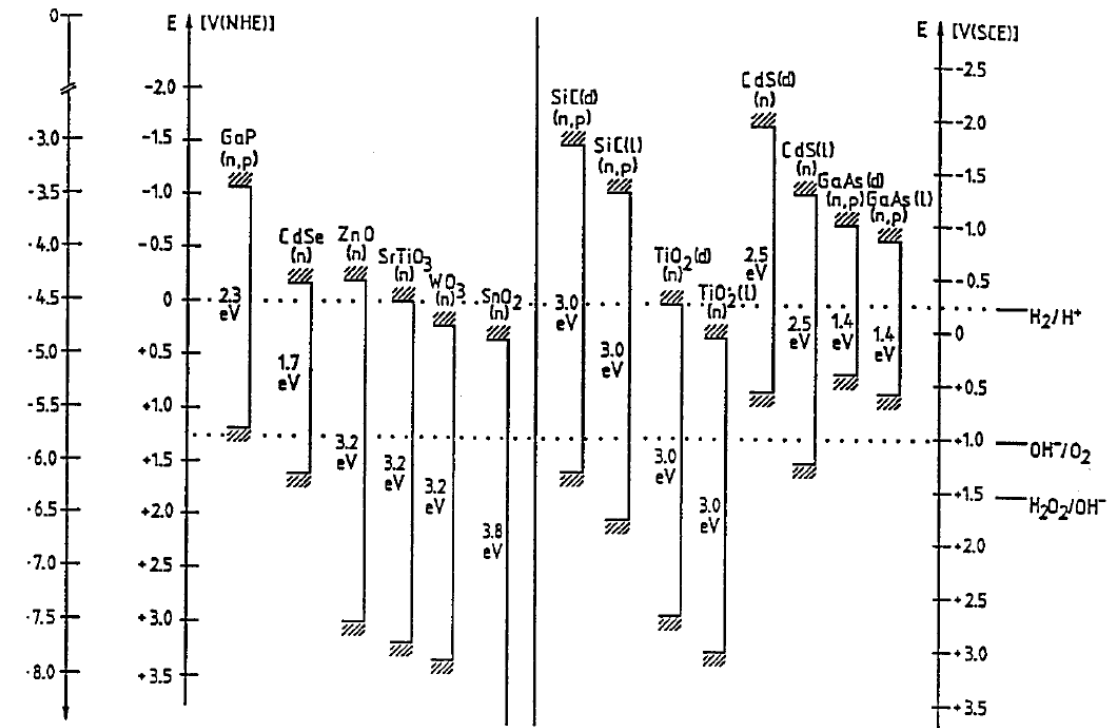
Figure 5. Position of energy bands of various semiconductors with respect to the electrochemical scale (adopted from Ref.